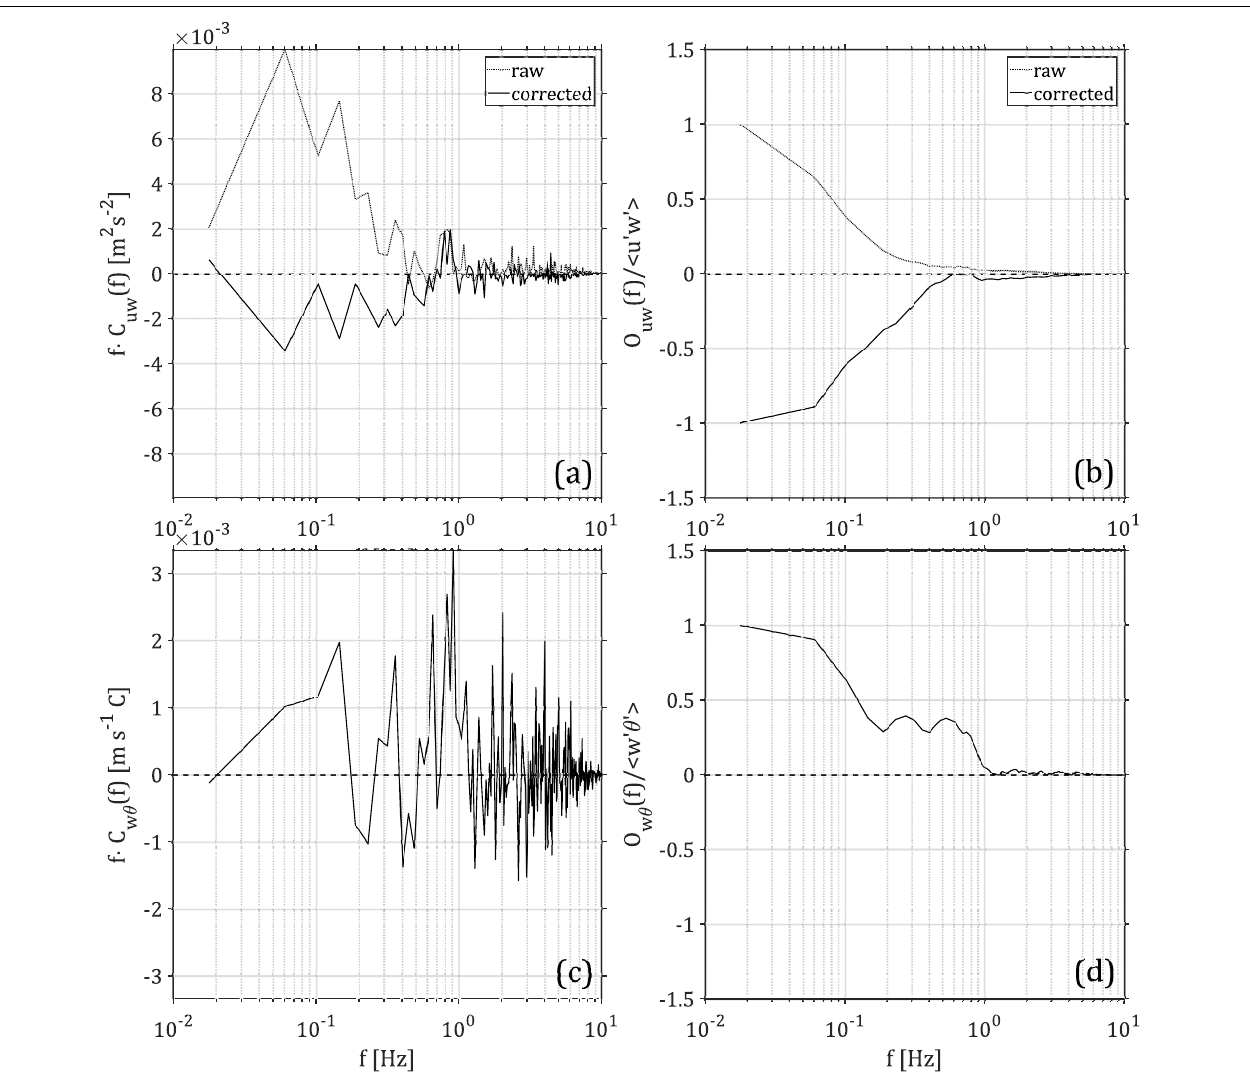
FIGURE 14 | Cospectra (a,c) and ogives (b,d) . Computed using the vertical velocity time series and the alongstream velocity (a,b) or the air temperature (c,d) . Ogives represent the cumulative flux density, with the lower limit of integration moving from right (high frequency) to left (low frequency). Integrating the cospectra yields wind stress τ = 0.0053 N m − 2 and sensible heat flux H s = − 2.6 W m − 2 . In both cases, positive is downward (into the ice/ocean), a negation of the values of the